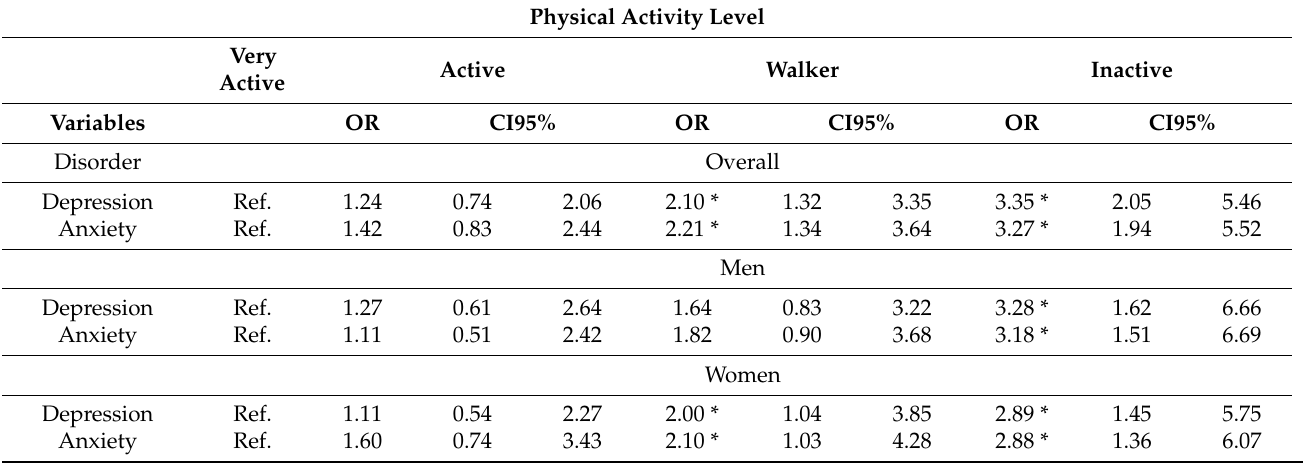
Table 2. Depression and Anxiety risks according to the Physical Activity Level in Spanish people with Hypertension (ENSE2017).